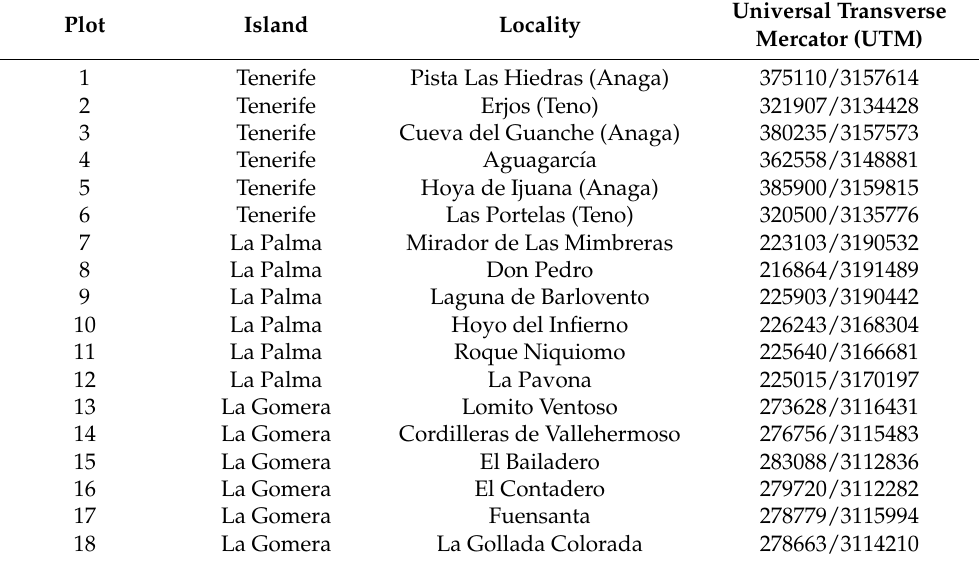
Figure 1. Field plots installed on potential area of humid laurel forest ( Lauro novocanariensis—Perseetum indicae ) in La Palma, La Gomera, and Tenerife islands. Table 1. Field plots.